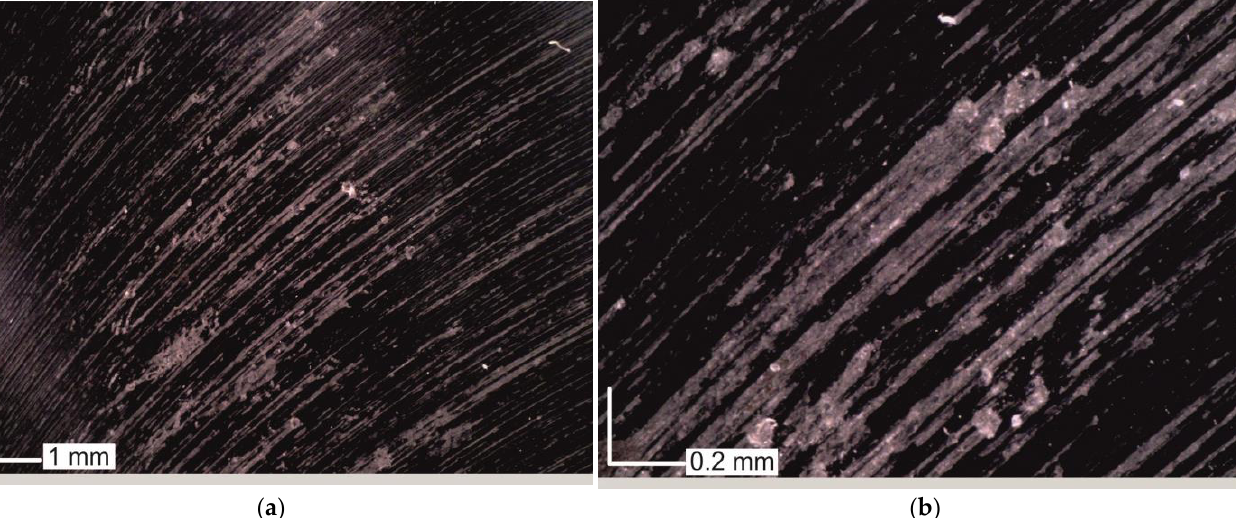
Figure 10. Surface after machining without cooling: ( a ) 100 times magnification; ( b ) 200 times mag- nification.